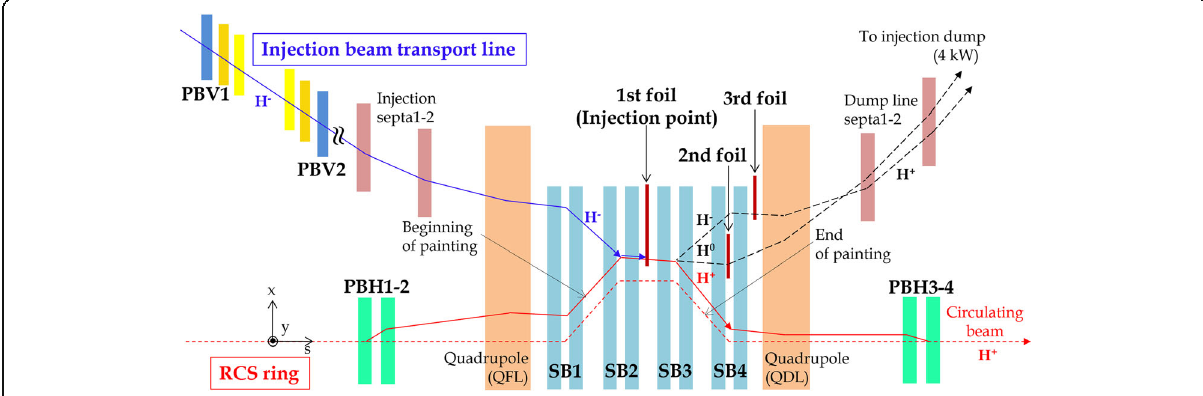
Fig. 11 Schematic of the injection system in the J-PARC